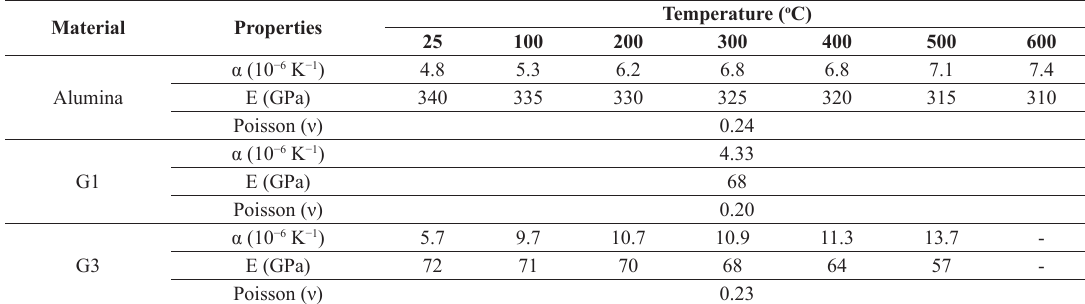
Table 1. Material properties (extracted from Tessier-Doyen 7